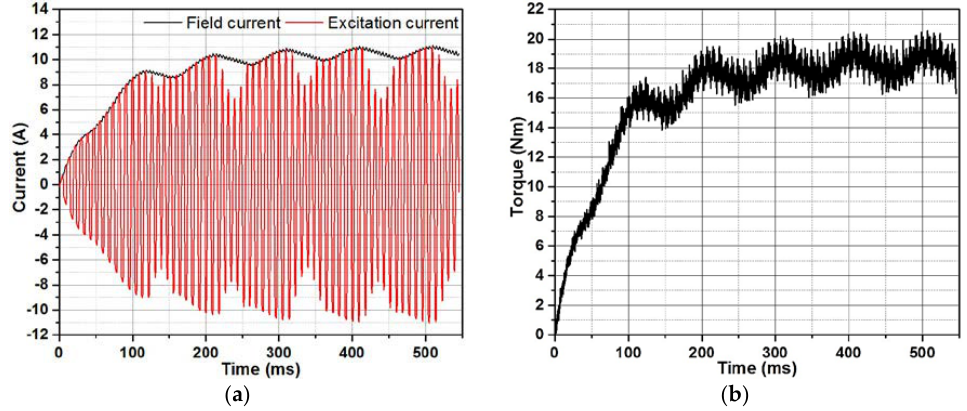
Figure 11. Optimal model performance ( a ) rotor currents and ( b ) electromagnetic torque.